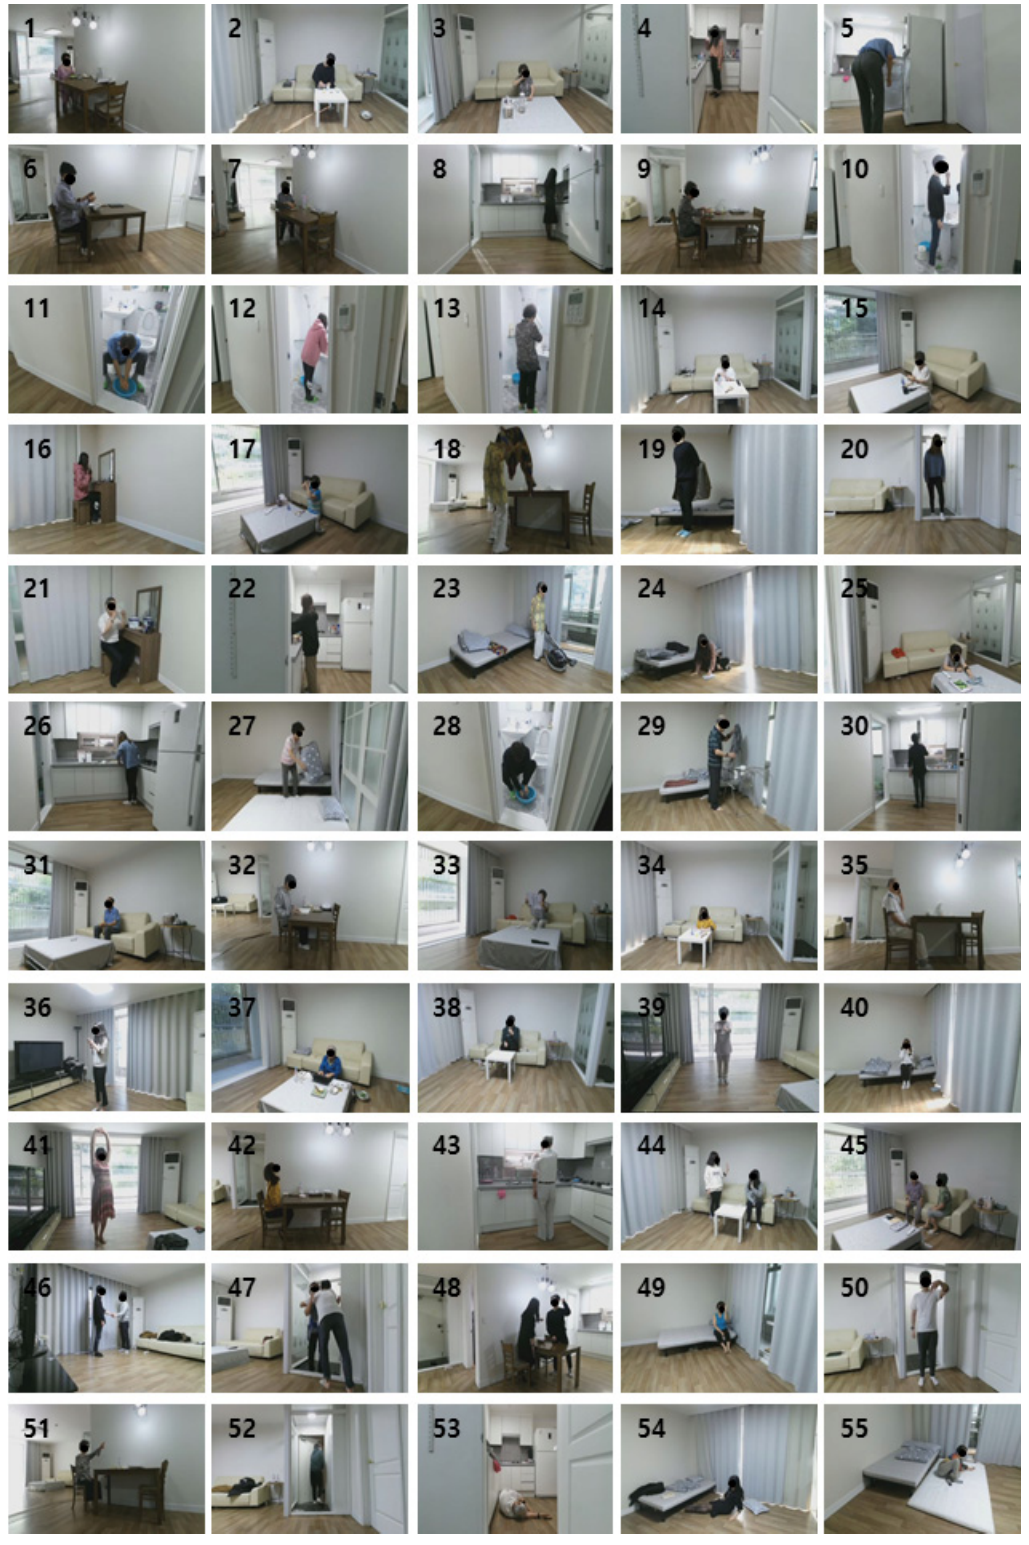
Figure 14. Examples of ETRI-Activity3D data.